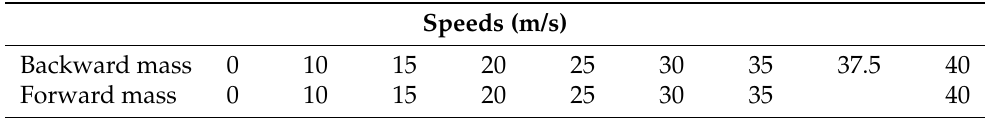
Table 3. Wind tunnel test speeds for each